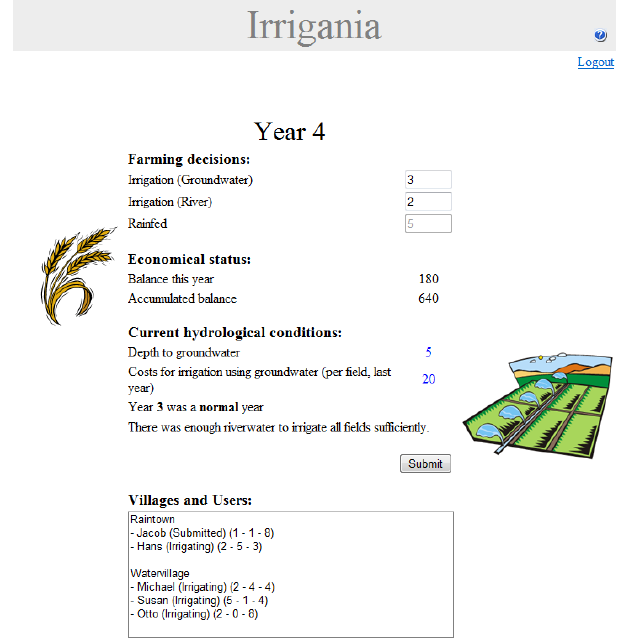
Figure 1. The student (farmer) web-interface during a game of Irri- gania showing the “Farming decisions” taken for Year 4, the “Eco- nomical status” based on Years 1–3, and “Current hydrological con- ditions” to base the current year’s decisions on.